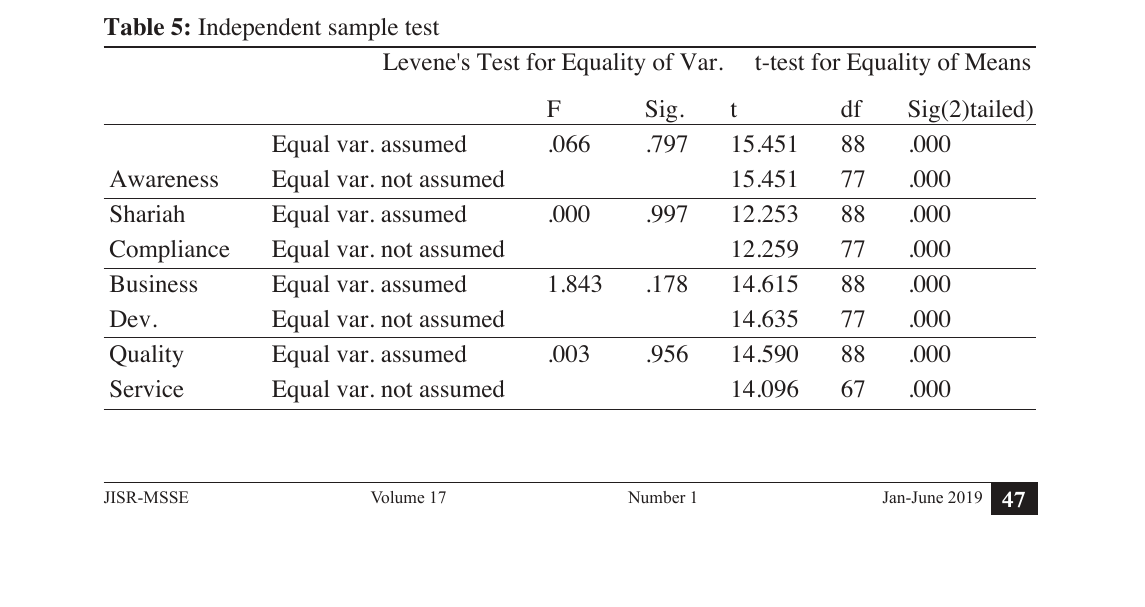
Table 5: Independent sample test Levene's Test for Equality of